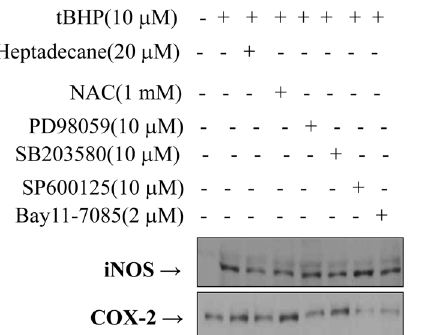
Figure 6. Heptadecane attenuated NF-kB-responsive COX-2 and iNOS via NIK/IKK and MAPKs. YPEN-1 cells were grown to 80% confluent in 100 mm dishes in DMEM. Cells were pre-treated (1 hr) with heptadecane (20 m M) and inhibitors and then stimulated with 10 m M t- BHP. After stimulation with t-BHP in the absence ( 2 ) or presence ( + ) of heptadecane and each kinase inhibitor, COX-2 and iNOS gene